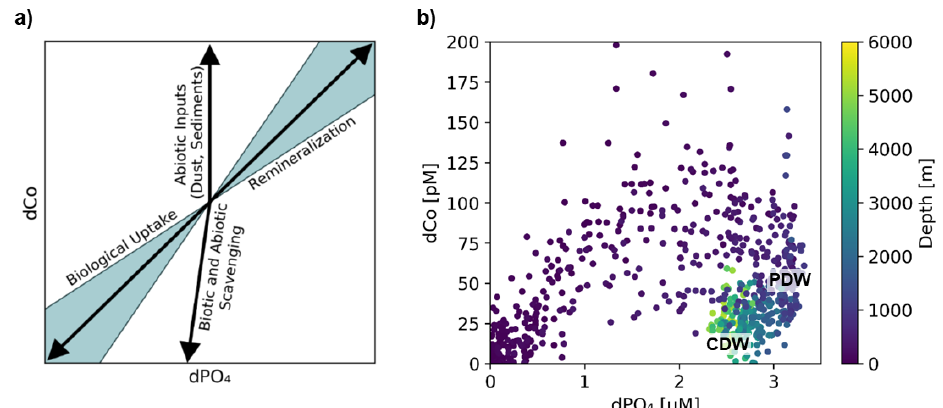
Figure 8. (a) A vector schematic showing the relationship between dCo and dPO 4 concentrations and the effects of major oceanic processes on nutrient distribution. Biological uptake and remineralization can exhibit a range of stoichiometric relationships, depicted here by the blue shaded region. Adapted from Noble et al. (2008). (b) Observed dCo vs. dPO 4 along the GP15 transect. Approximate positions of Circumpolar Deep Water (CDW) and Pacific Deep Water (PDW) are marked.